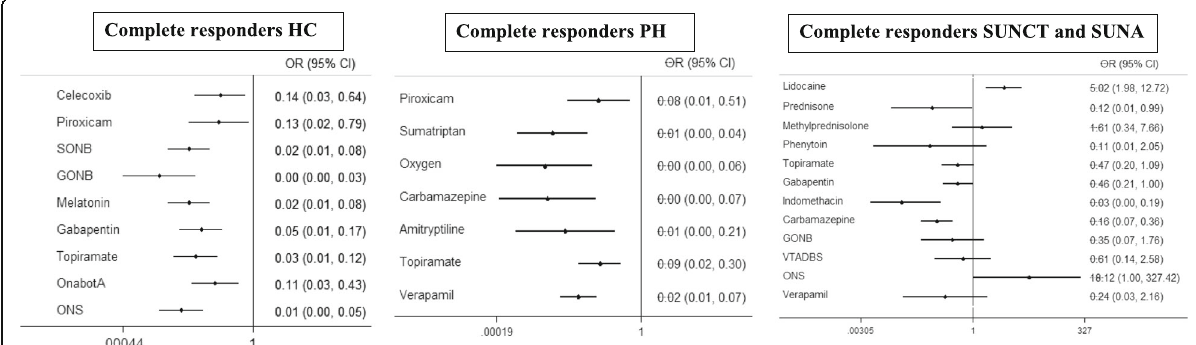
Fig. 2 Odds ratios of complete responders. For HC and PH the referral treatment is indomethacin. For SUNCT and SUNA the referral treatment is lamotrigine. If the whole 95% CI of the OR is lower than 1, the referral treatments is better than the reported